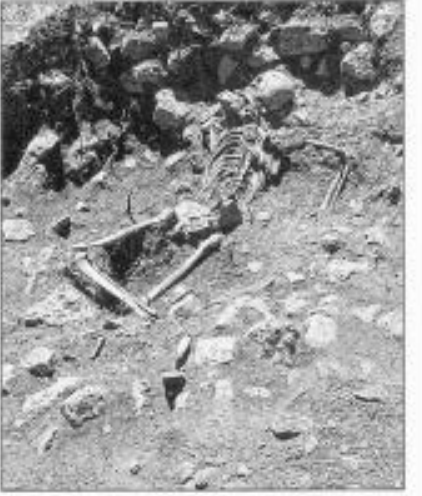
Figure 2 The skeleton of a Second World War machine gunner exposed during archaeological excavation on Bezymyan­ naya